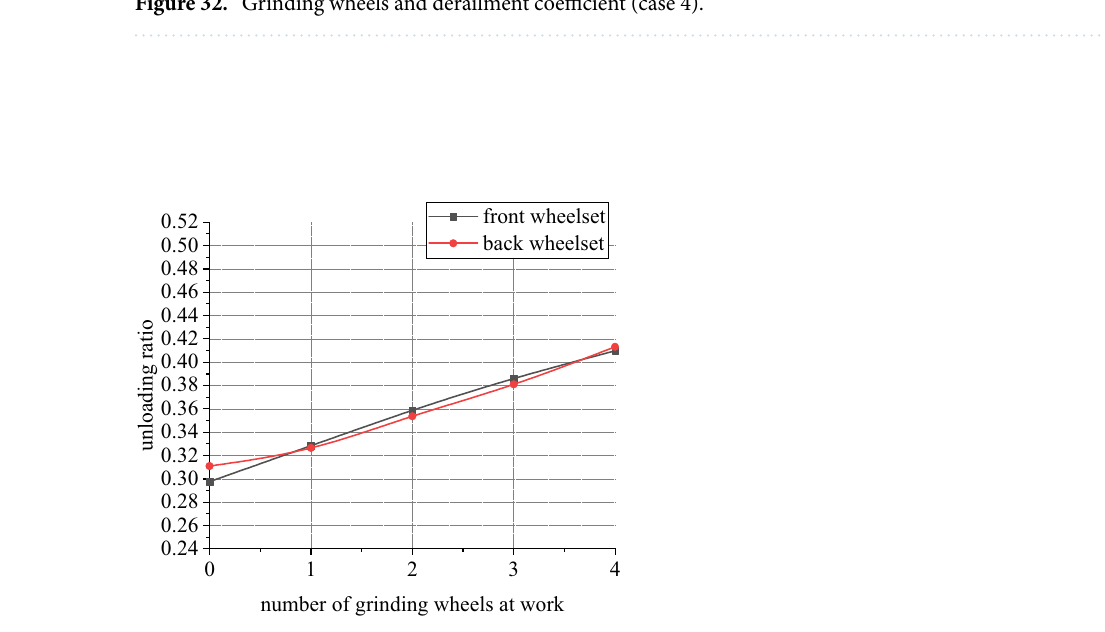
Figure 32. Grinding wheels and derailment coefficient (case 4).